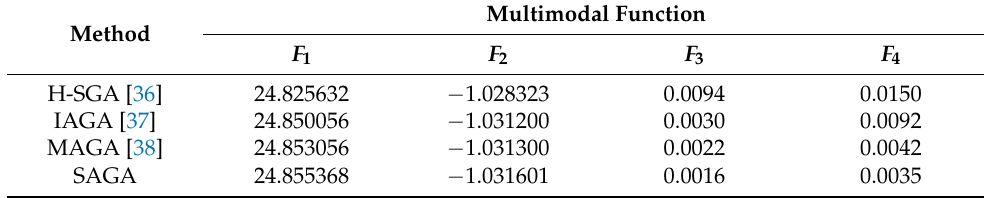
Table 3. Average convergence